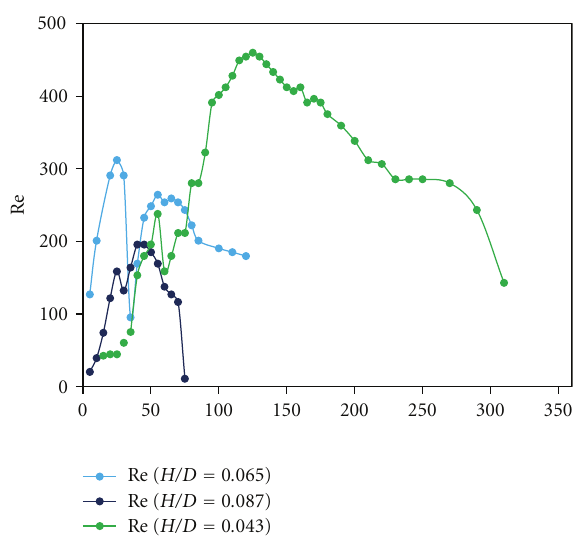
Figure 11: The Reynolds number of water under di ff erent H/D ratios.